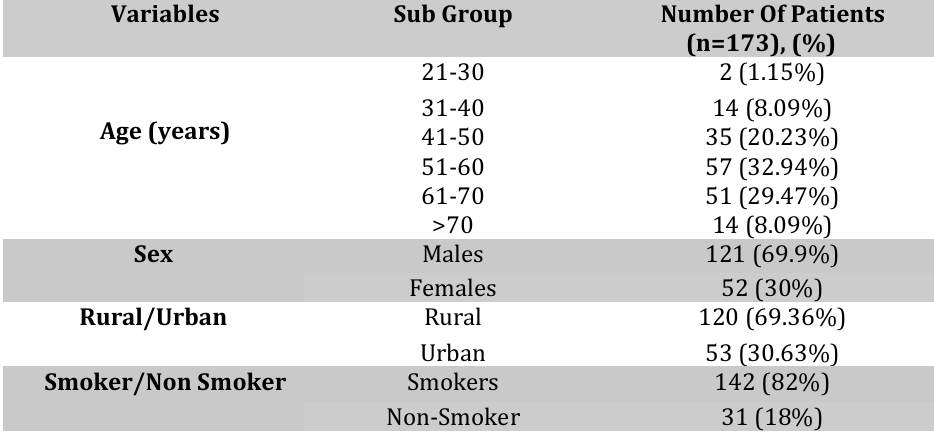
Table 1. Demographic characters (Age and sex distribution, place of residence, smoking habits) of cases with lung